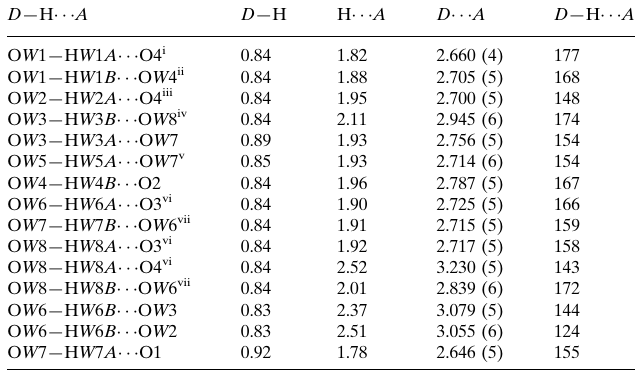
Hydrogen-bond geometry (A ˚ , (cid:3) ). D —H (cid:2)(cid:2)(cid:2) A D —H H (cid:2)(cid:2)(cid:2)